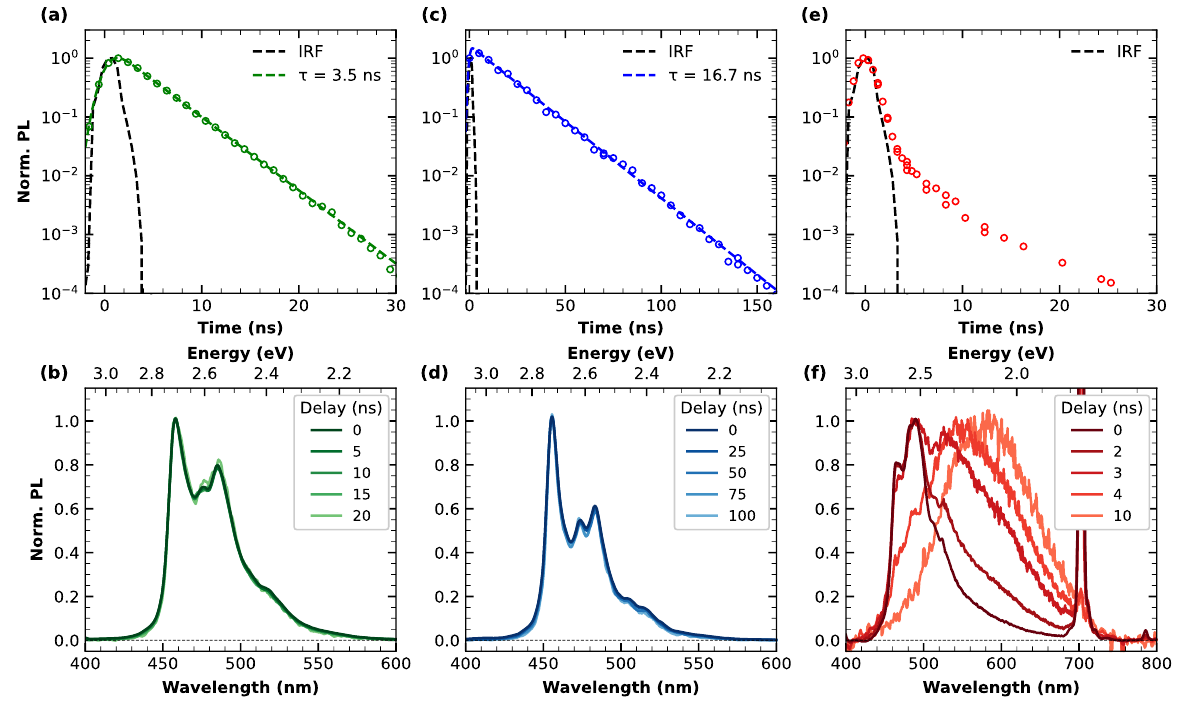
Figure 2. Top panels: normalized emission decay and respective least-squares fitting curves (dashed lines) of ( a ) c-NG , ( c ) m-NG and ( e ) c-Br-NG , acquired at λ exc = 350 nm and λ em = 460 nm. Bottom panels: normalized emission spectra of ( b ) c-NG , ( d ) m-NG and ( f ) c-Br-NG , acquired at different delays from photoexcitation.